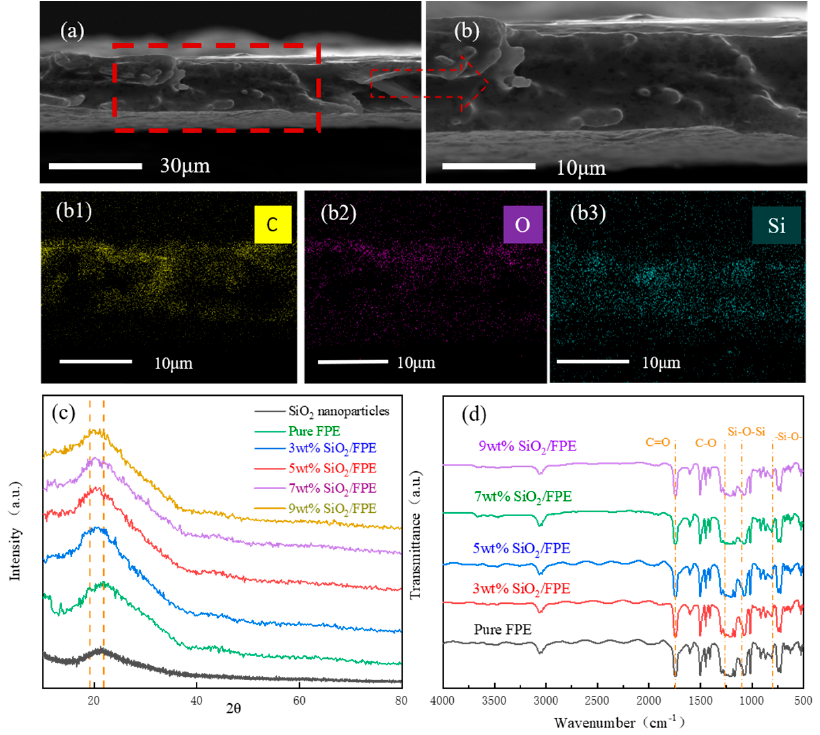
Figure 2. SEM images of a fractured cross-section of the composite film are shown in ( a , b ); elements mapping of SiO 2 /FPE composite film in ( b1 – b3 ); XRD images of SiO 2 nanoparticles and SiO 2 /FPE in ( c ); and FTIR images of SiO 2 /FPE in ( d ).